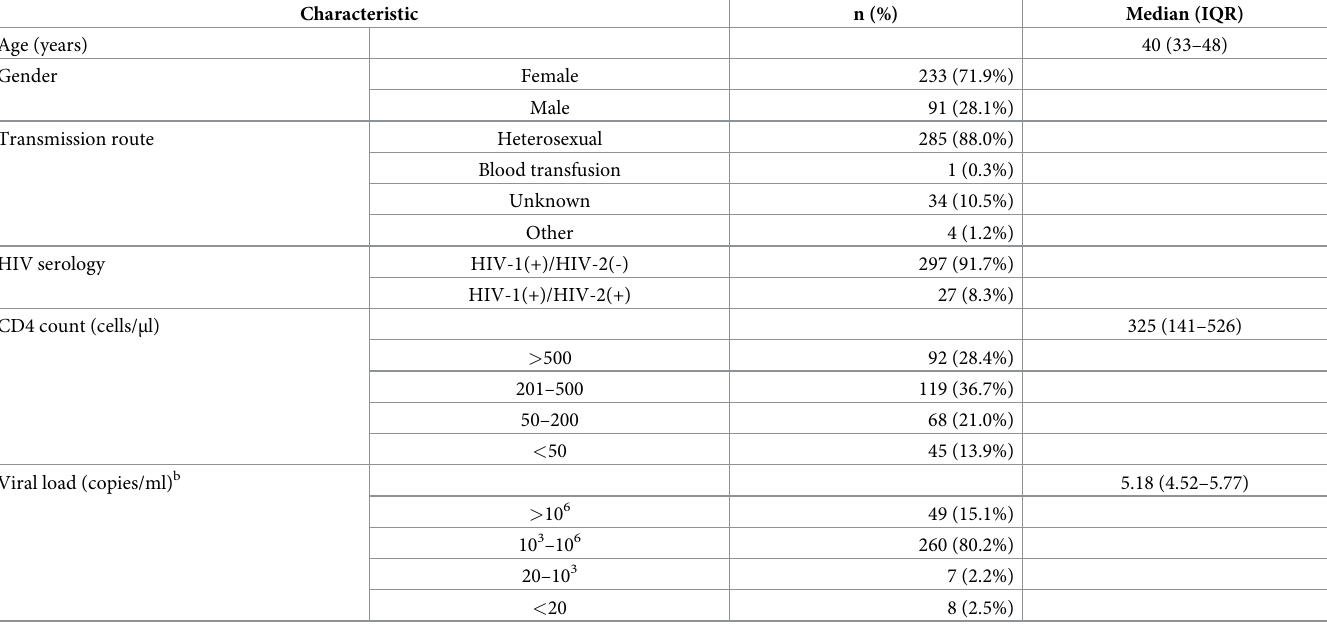
Table 1. Clinical information of samples (n = 324) a